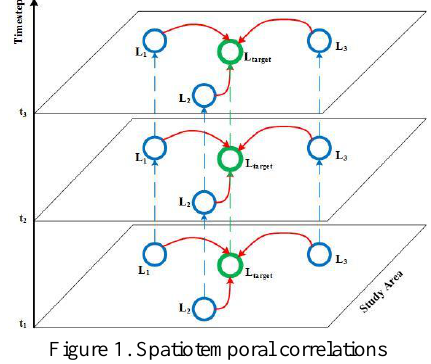
Figure 1. Spatiotemporal correlations